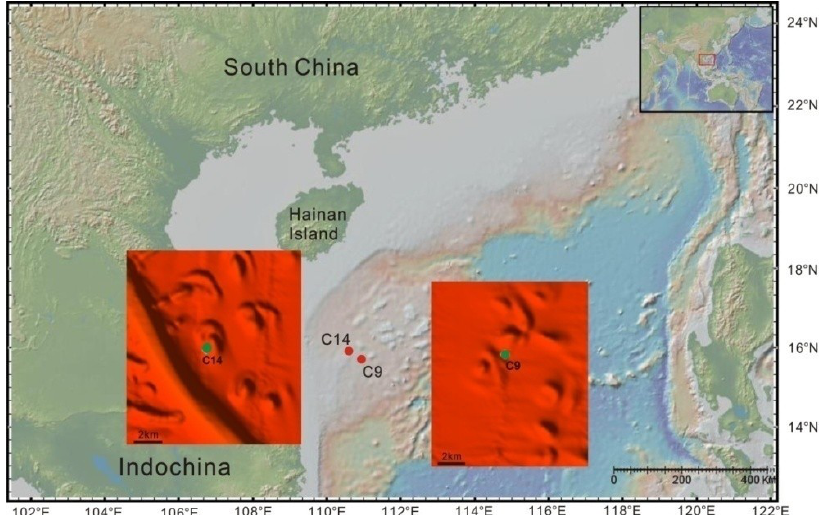
Figure 1. Sampling location of sediment cores. The insets are the multibeam bathymetry maps showing sampling sites relative to